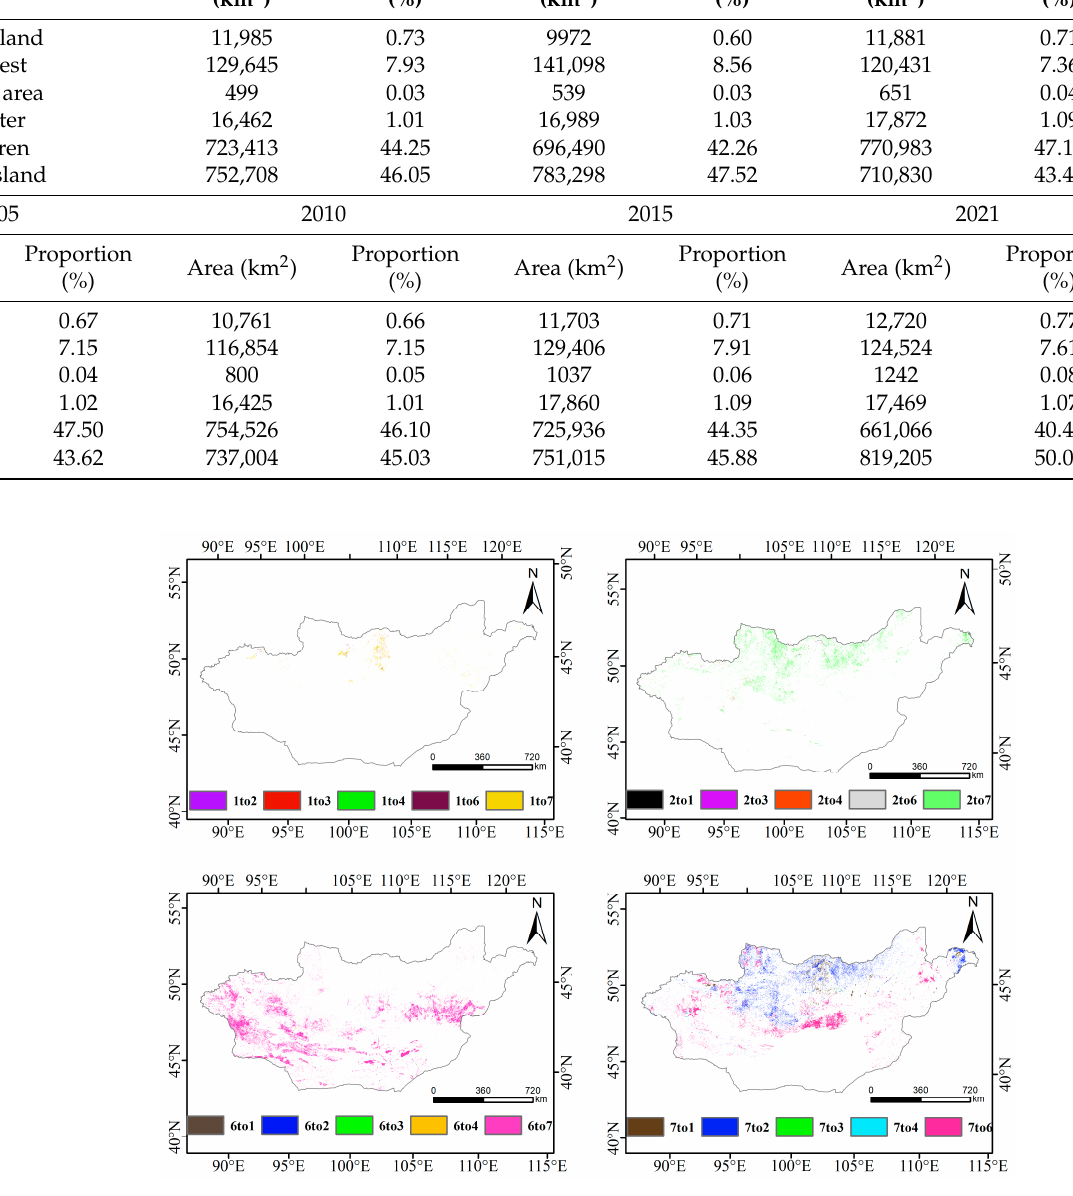
Figure 6. Land use change in Mongolia from 1990 to 2021; 1—cropland, 2—forest, 3—built area, 4—water, 5—barren, and 6—grassland. Table 3. The areas of different land use types in Mongolia from 1990 to 2021.